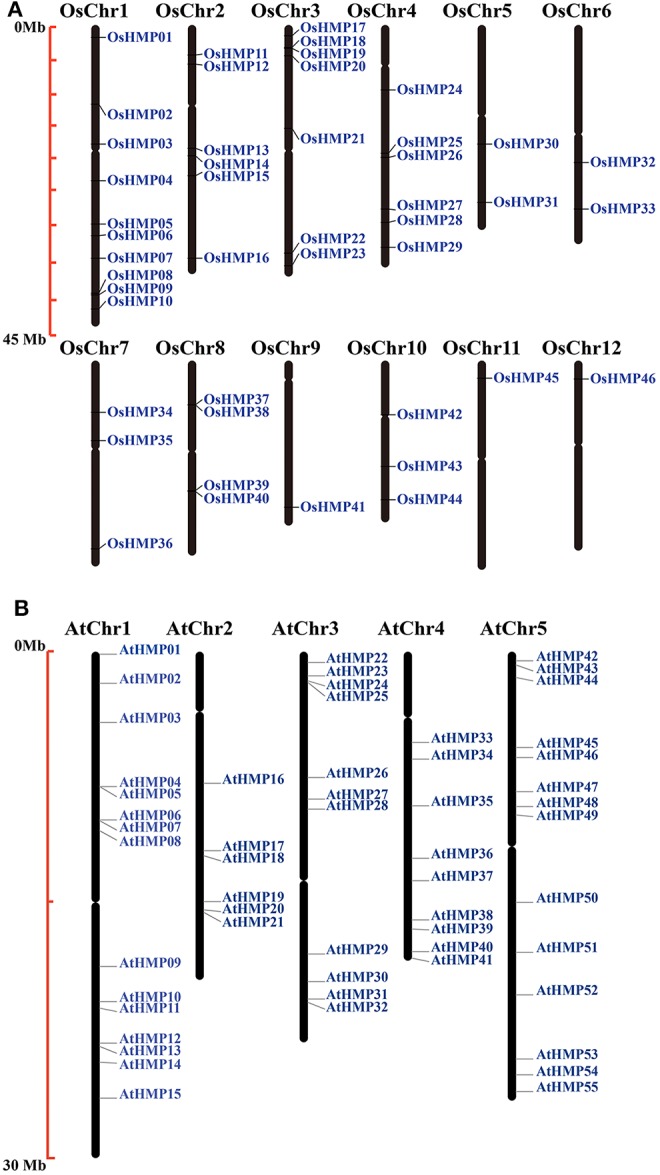
Chromosomal locations of heavy-metal-associated genes in rice (A) and Arabidopsis
(B). Black bars represent the chromosomes. Chromosome numbers are shown at the tops of the bar. Heavy-metal-associated genes are labeled at the right of the chromosomes. Scale bar on the left indicates the chromosome lengths (Mb).